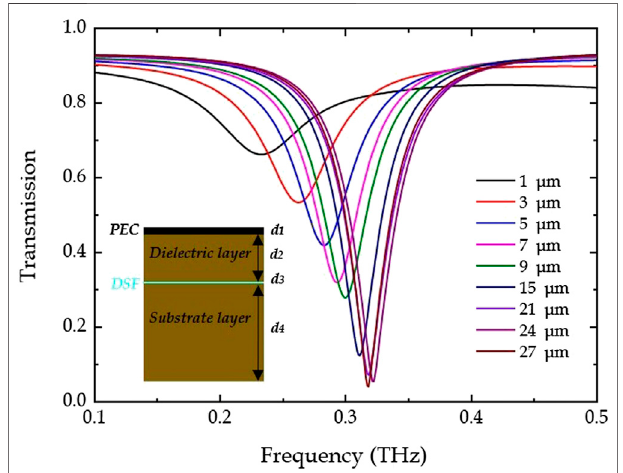
FIGURE 4 | Simulated transmission spectra as a function of the thickness of the dielectric layer (d 2 ) with E F (cid:2) 30 meV and the thickness of the perfect electric conductor (PEC), Dirac semimetal fi lm (DSF), and substrate layer set as d 1 (cid:2) 0.2 μ m, d 3 (cid:2) 30 nm, and d 4 (cid:2) 50 μ m, respectively. (inset) The cross-sections of the model are